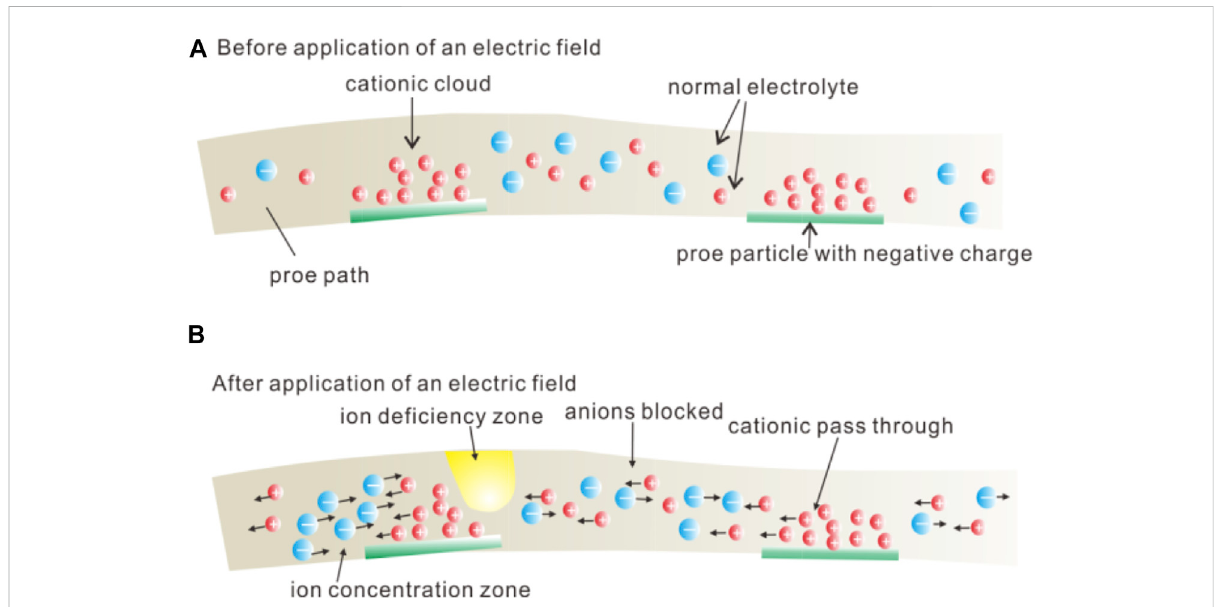
FIGURE 2 Schematic diagram of membrane polarization in rock containing clay particles and (A) rock with clay before the application of an electric fi eld; (B) after the application of an electric fi